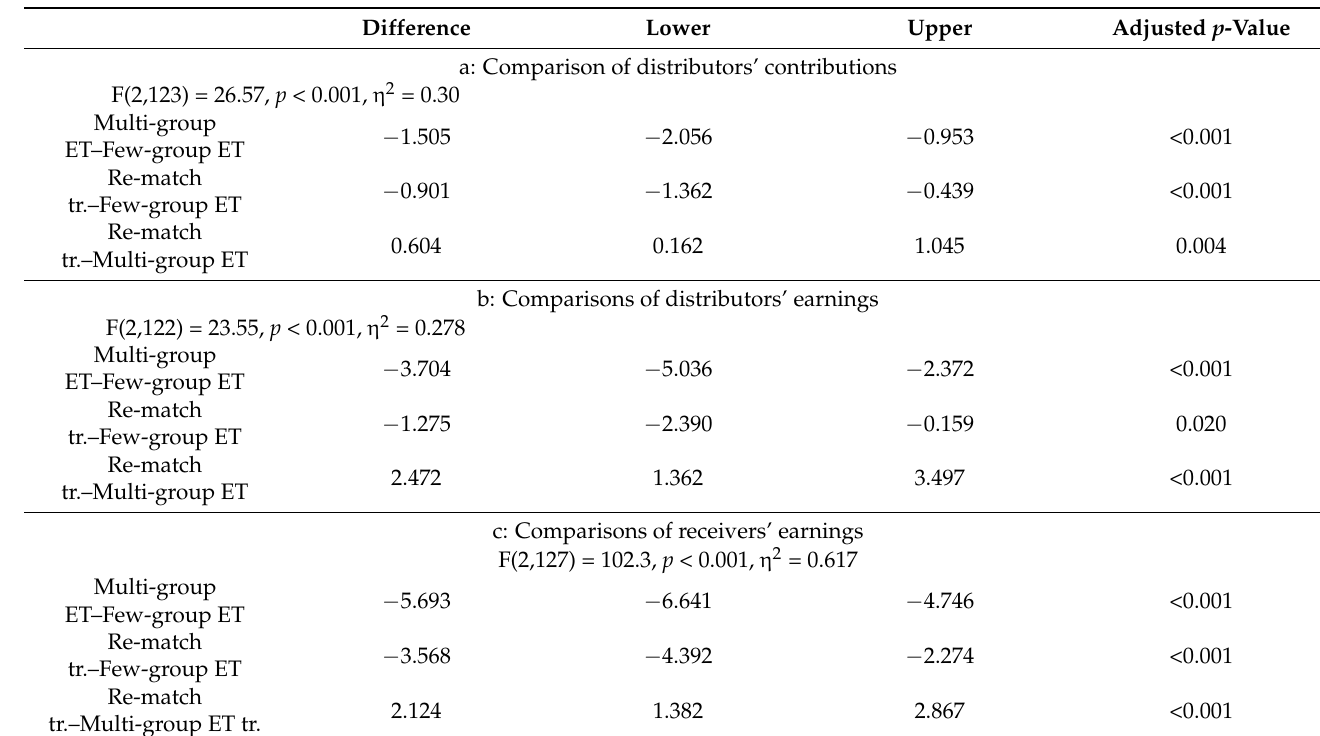
Table 4. Values for the 95% family-wise confidence level, Tukey’s "Honest Significant Difference" method. For RT we used the contributions/the total earnings of all distributors/subjects (distributors: 74, receivers: 74) of RT; for the multi-group ET the contributions/total earnings of all distributors/subjects that were in at least 9 groups (distributors: 27, receivers: 32), and for few-group ET the contributions/total earnings of all of all distributors/subjects that had were in at most 4 groups for both (distributors: 24, receivers: 24).